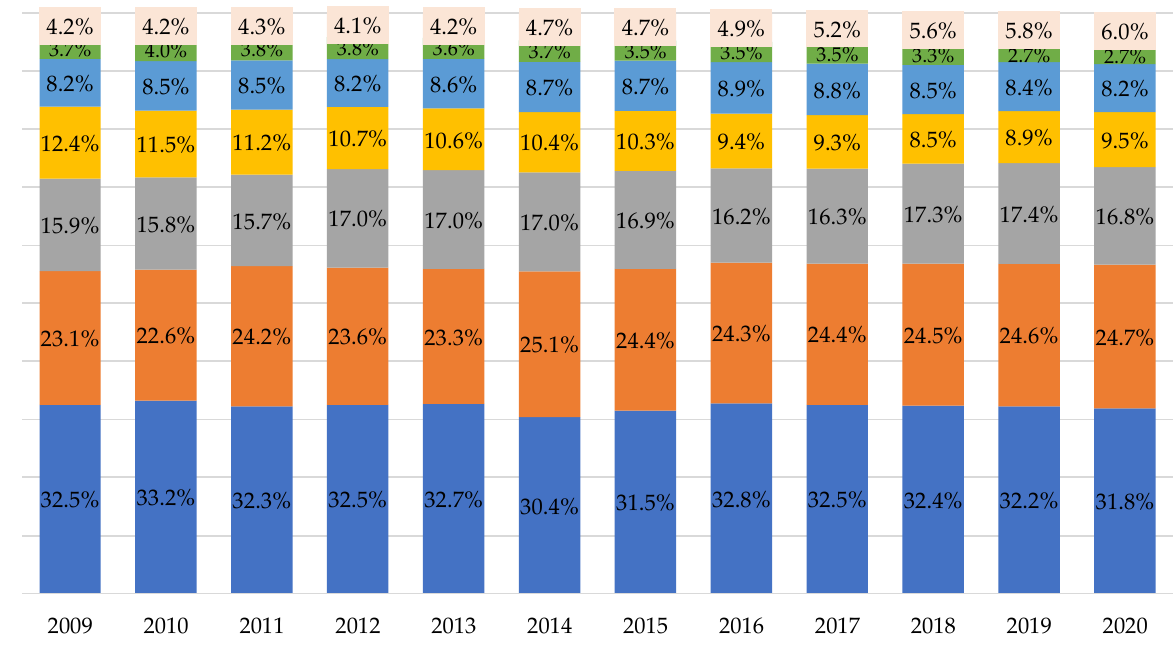
Figure 1. The structure of final energy consumption in households by type of fuel in the EU. Source: own elaboration based on EUROSTAT [40]. * Others—including: liquefied petroleum gases, ambient heat (heat pumps), other kerosene, solar thermal.